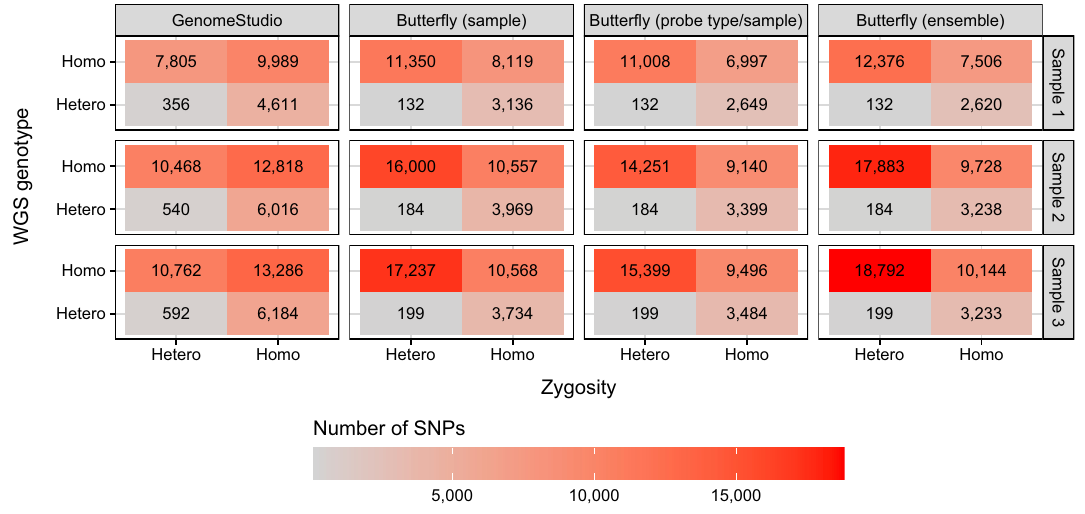
Figure 8. Discordant calls (excluding no-calls) for the samples with 400 ng DNA in Fig. 7 summarised to homozygous and heterozygous calls. The butterfly methods had an a posteriori probability threshold of 0.8 and a number of beads threshold of 0. See Fig. 7 for results for all genotypes. There is no obvious structure in these discordant calls, except possibly a small indication that all methods seem to call too few homozygous genotypes.